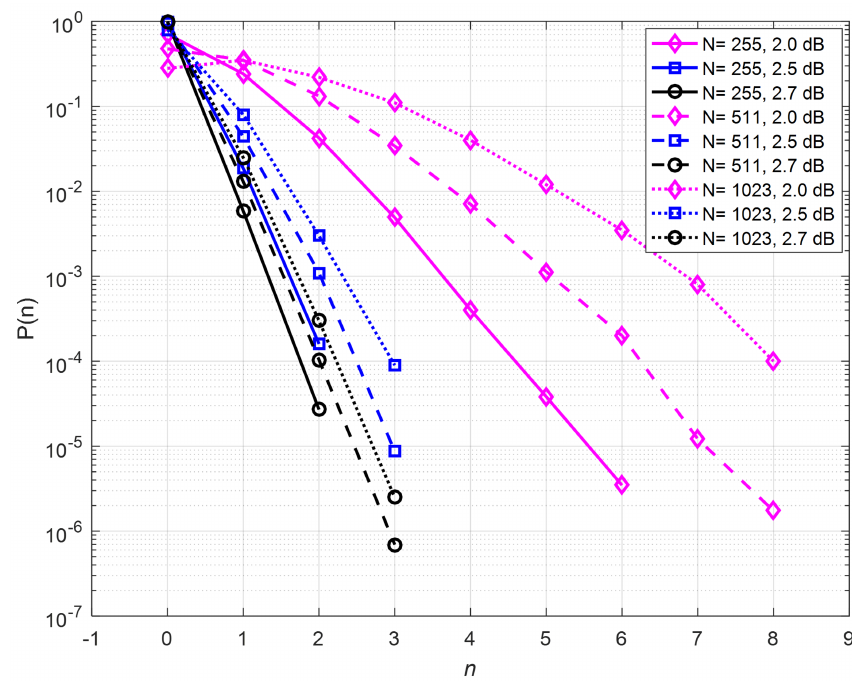
Figure 4. The probability distribution of the number of erroneous information